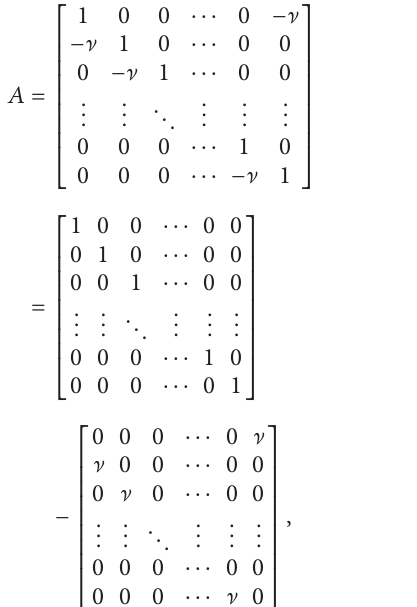
Table 1: Convergence results of Theorems 16 and 18. (𝛼, 𝛽,𝛽 , 𝛾 , 𝜔) 𝑖 𝑖